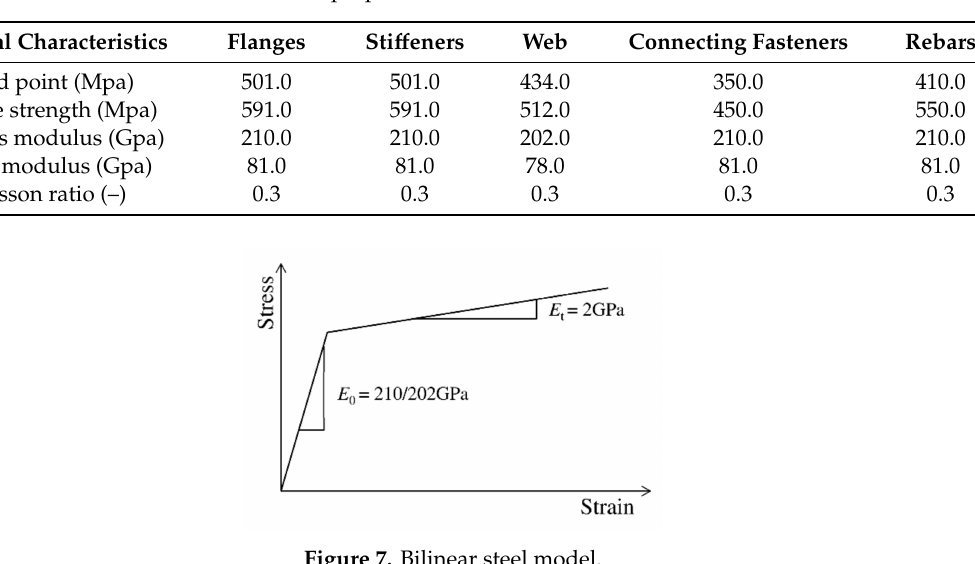
Table 1. Material properties of steel in the numerical model.